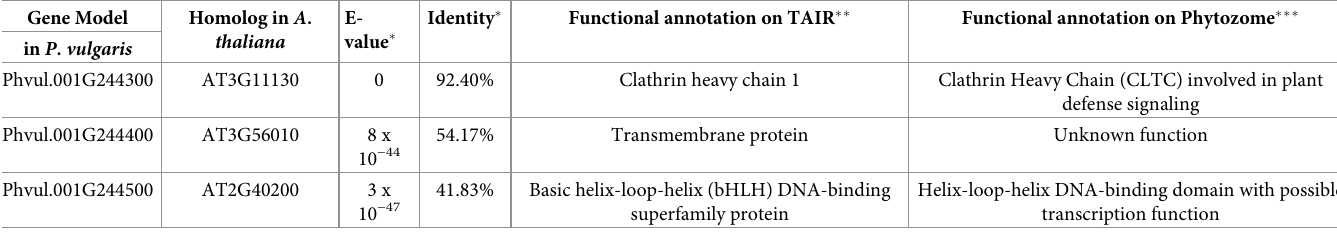
Basic helix-loop-helix (bHLH) DNA-binding superfamily protein